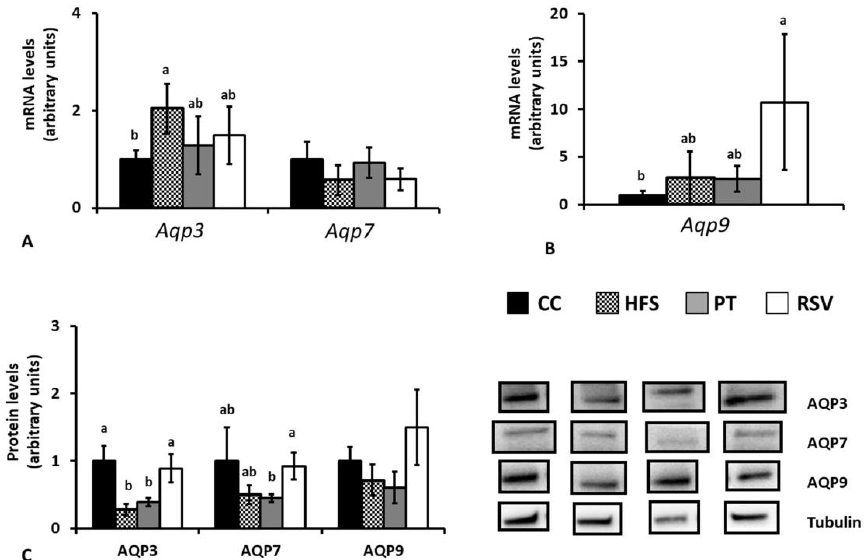
Figure 5. Epididymal adipose tissue aquaglyceroporin gene ( A , B ) and protein ( C ) expressions Different letters indicate statistically significant differences. Aqp3 and AQP3: aquaglyceroporin 3, Aqp7 and AQP7: aquaglyceroporin 7, Aqp9 and AQP9: aquaglyceroporin 9.